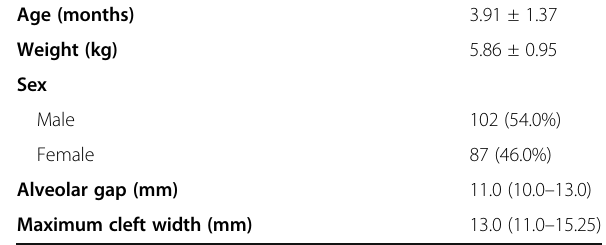
Table 1 Summary of the demographic and clinical characteristics of the study